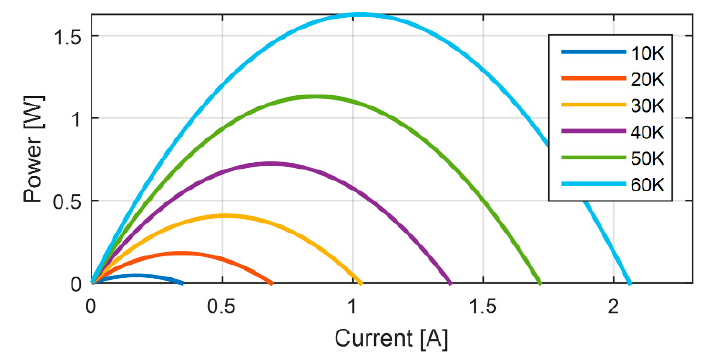
Figure 6. P–I Characteristic Curve.